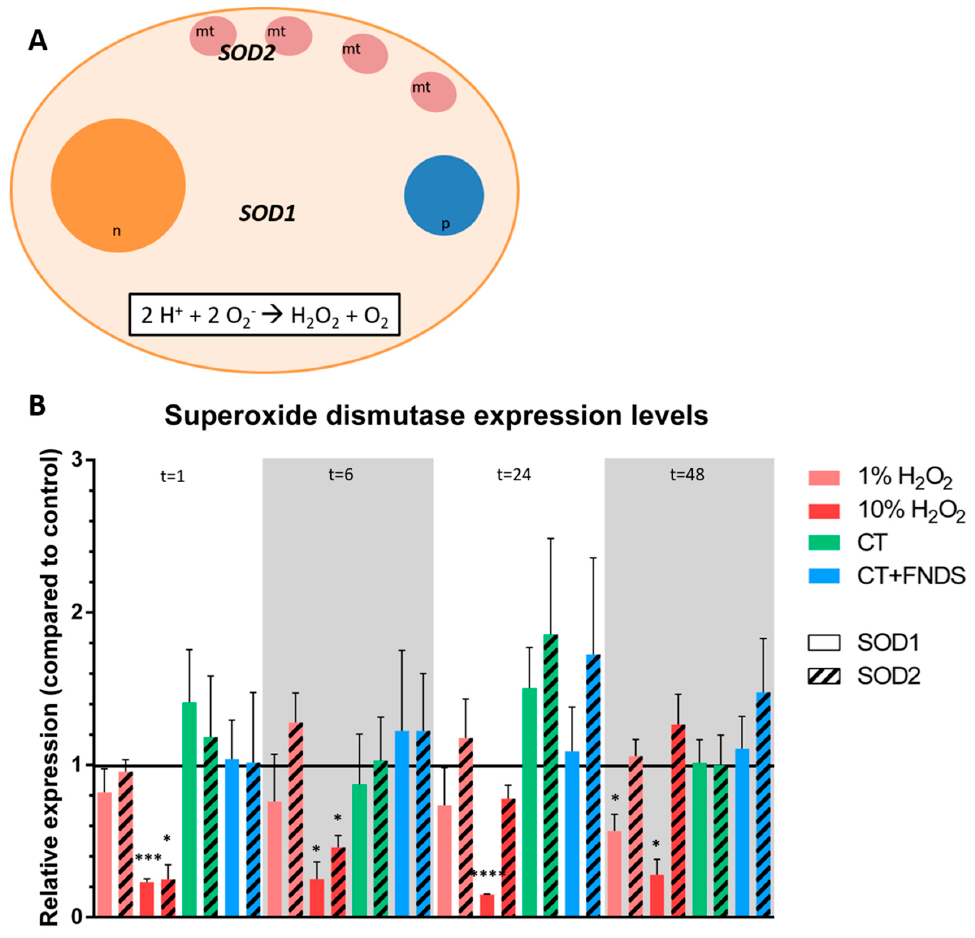
Figure 3. ( A ) Schematic representation of the cell showing the locations of superoxide dismutase activity, including the reaction that is catalyzed by the superoxide dismutase enzyme at both the cytoplasm (SOD1) and the mitochondria (SOD2). (n = nucleus, mt = mitochondria, p = peroxisome); ( B) Relative expression of superoxide dismutase at different time-points: superoxide dismutase [Cu-Zn] which is present in the cytoplasm (SOD1, filled bars) and mitochondrial superoxide dismutase [Mn] (SOD1, striped bars). The colors represent different conditions, measured at 1/6/24/48 hours, respectively. Values are averages out of 3–4 independent qPCR runs that were performed in duplicates. Error bars show the standard error of the mean. Significance was tested against the control (* p ≤ 0.05, ** p ≤ 0.01, *** p ≤ 0.001, **** p ≤ 0.0001).